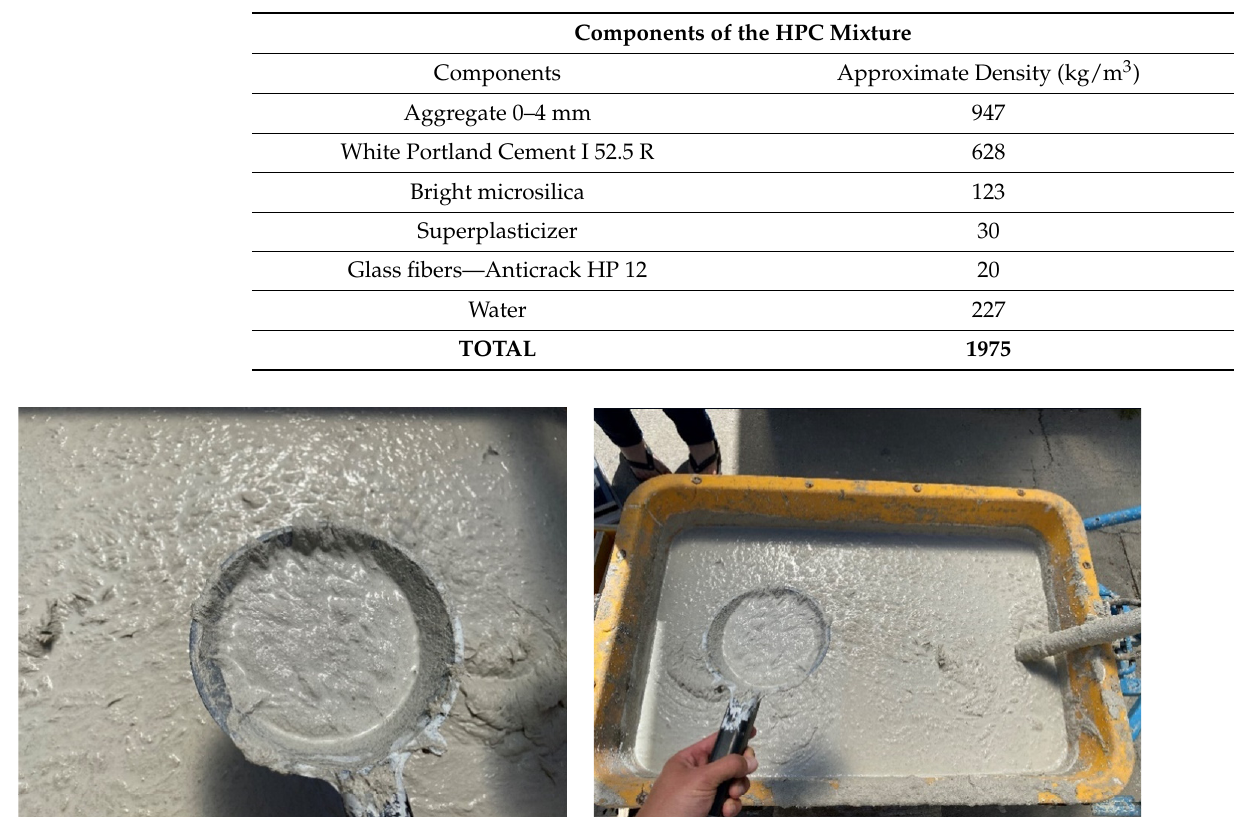
Table 1. Components of the HPC mixture.